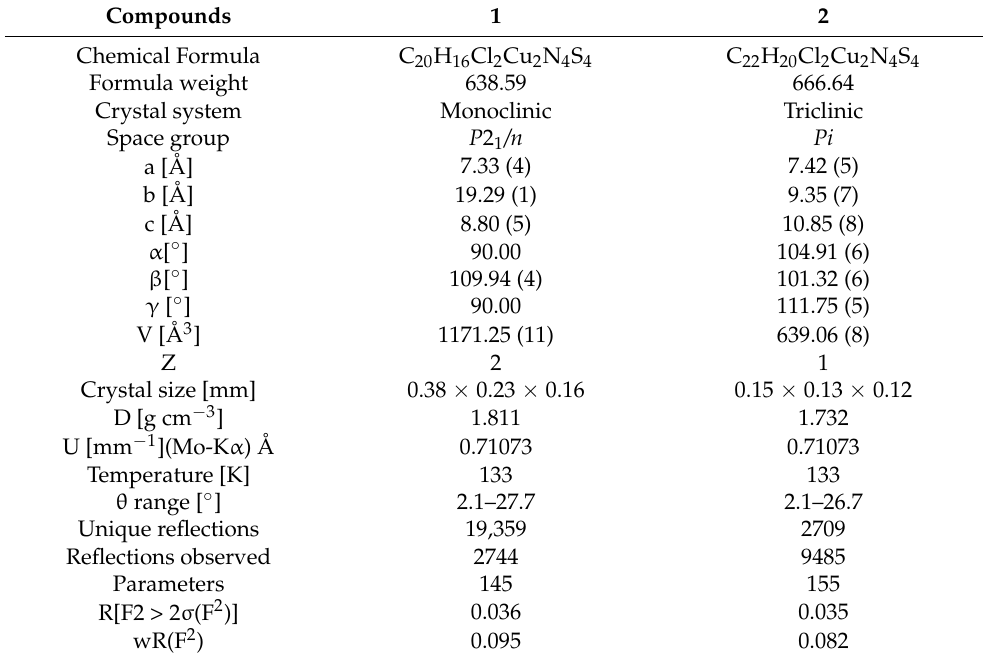
Table 1. Data pertinent to crystal-structure determination and refinements of compound 1 and 2.